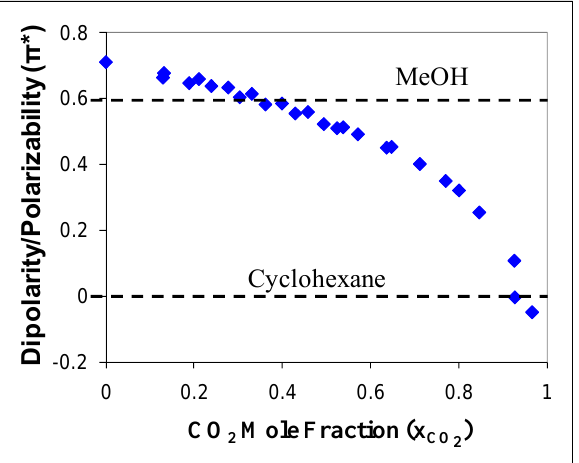
Figure 1. Kamlet-Taft dipolarity and polarizability ( π *) of acetonitrile/CO function of CO mole fraction 2